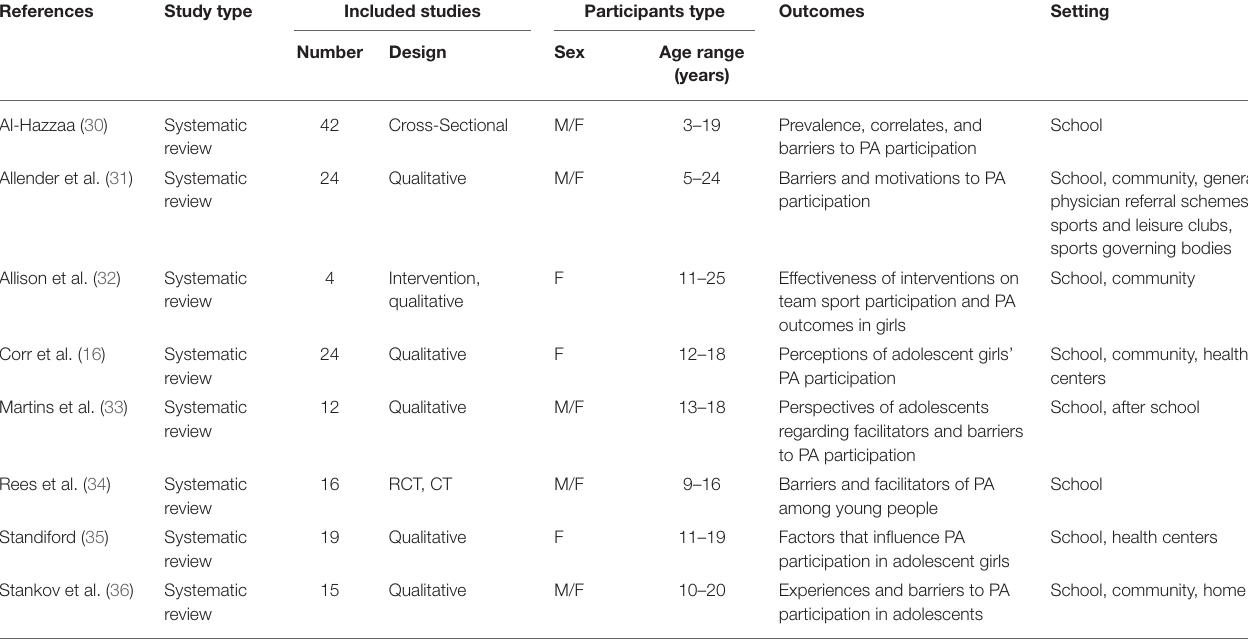
TABLE 1 | Characteristics of the included